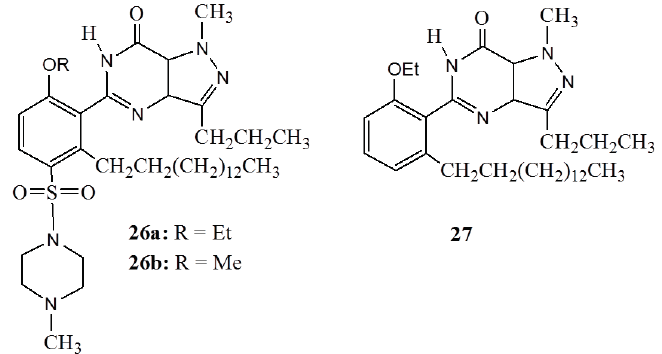
Figure 10. The sildenafil analogues 26 and 27